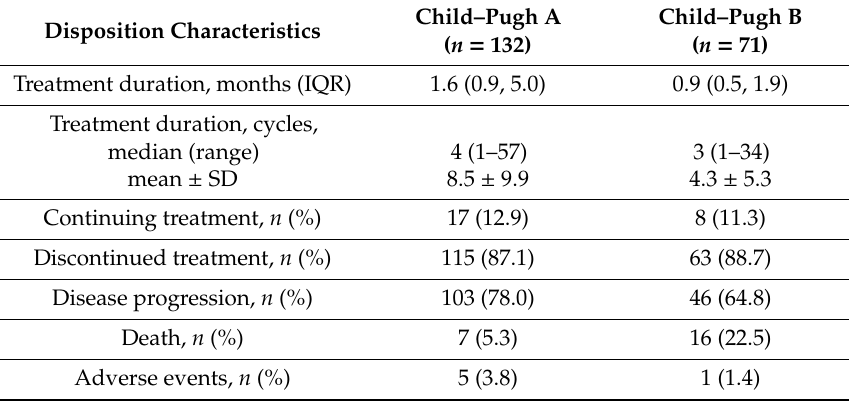
Table 2. Treatment summary of the study population.